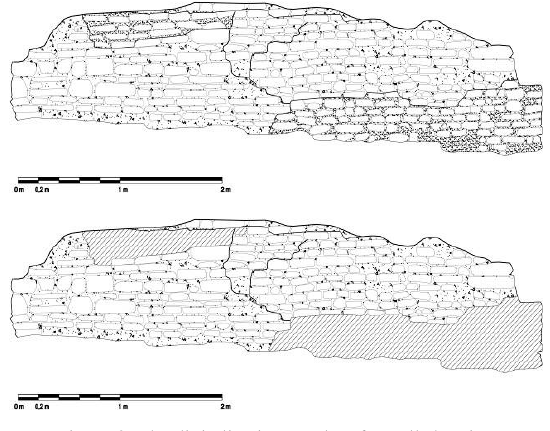
Figure 8. The digitalization results of a wall showing restorations and the fractures (lower